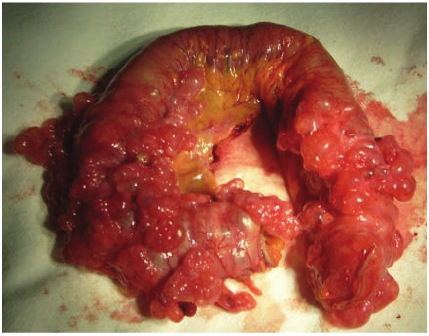
Figure 4: Gross appearance of the resected jejunum revealing multiple gas-filled cysts distributed within the bowel